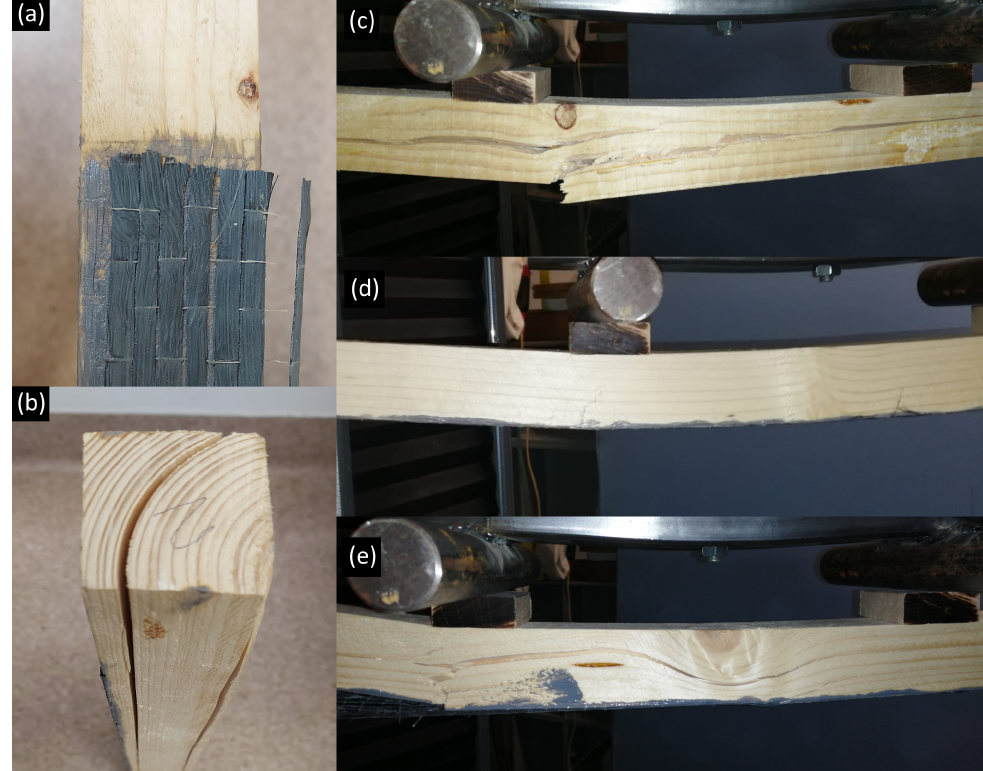
Figure 6. Failure. ( a ) Defected specimens with reinforcement slipping. ( b ) Defected specimens with cylindrical crack. ( c ) Non-reinforced specimen, tension failure. ( d ) Reinforced specimen, formation of a crack in the tension zone. ( e ) Reinforced specimen, fibre deviation around a knot and crack in the tension